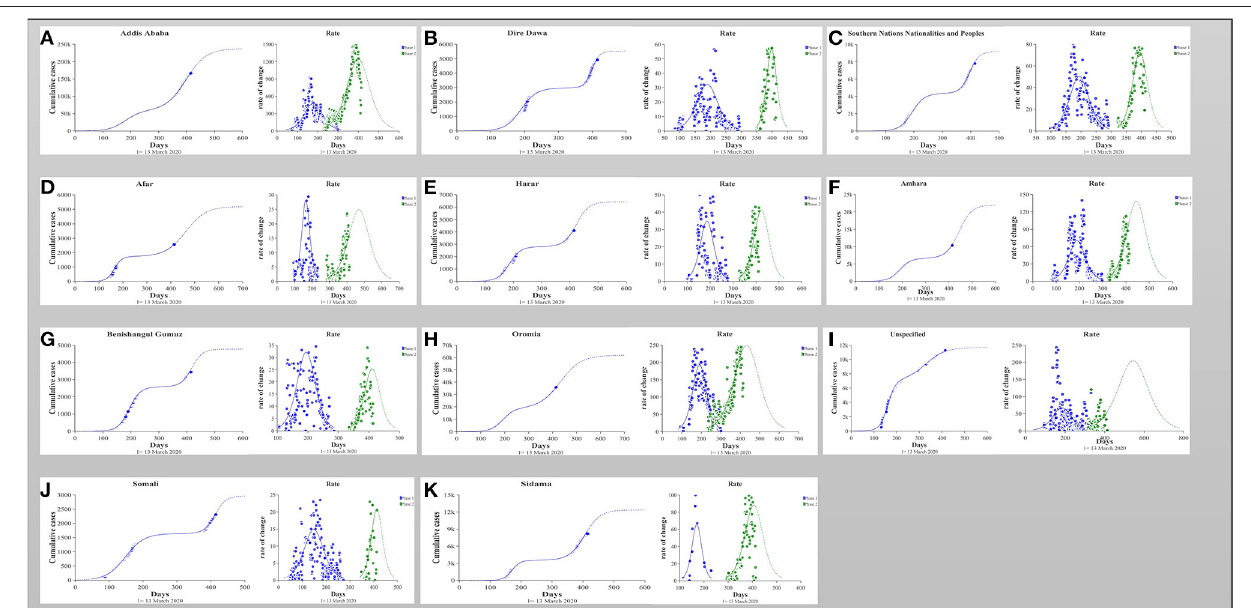
FIGURE 2 | (A–K) The number of cumulative cases was calibrated to a simple bi-logistic function, which was used to model biologic patterns with two growth waves. The parameters K represent the asymptotic value that bound the function and therefore specify the level at which the cases saturate; t m represents the midpoint of the epidemic growth and hence the peak of the outbreak; 1 t are the lengths of time intervals required for the epidemic to grow from 10 to 90% of the saturation level.